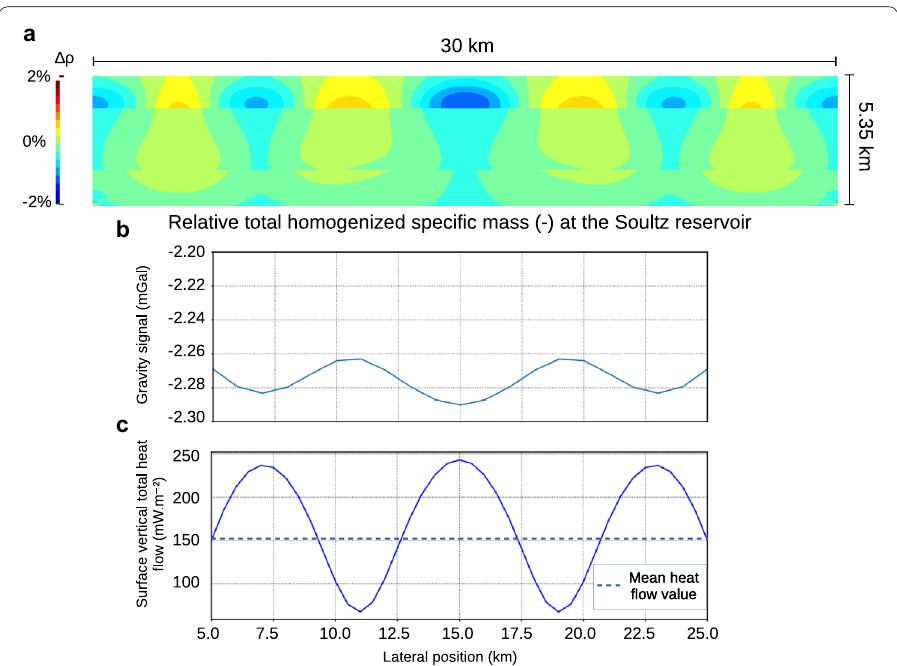
Fig. 6 a Map of the simulated relative variation of the total homogenized specific mass, i.e., the density of the homogenized medium associated to the hydrothermal circulation at the Soultz reservoir. b Associated synthetic gravimetric profile along the x -axis. c Profile of the computed vertical surface heat flow along the x -axis. The dotted line corresponds to the mean value of the heat